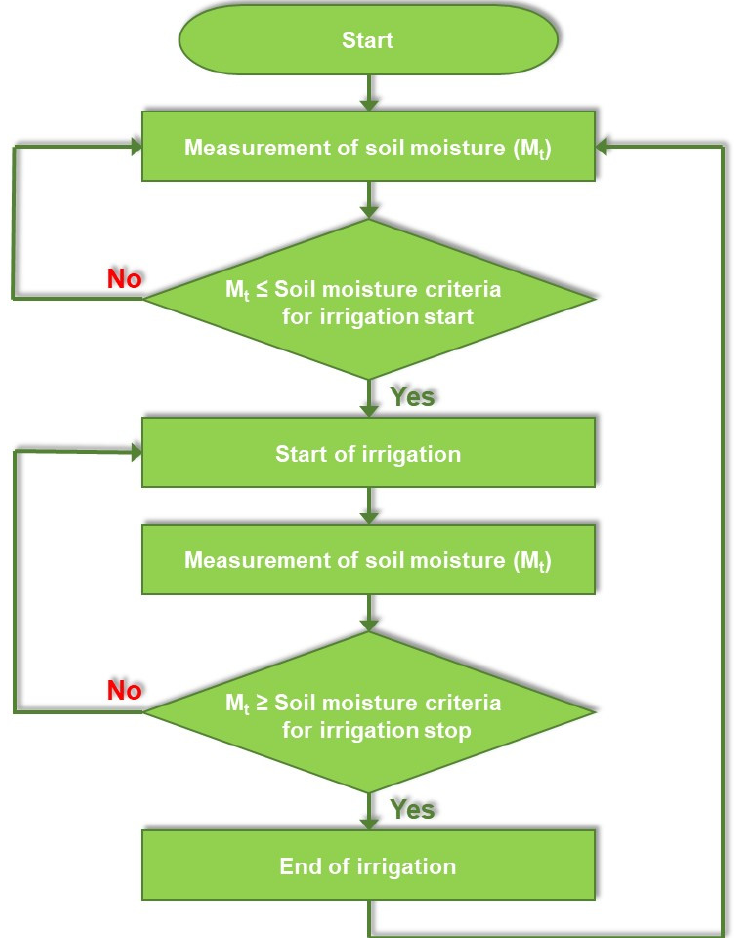
Figure 1. The existing algorithm for irrigation.